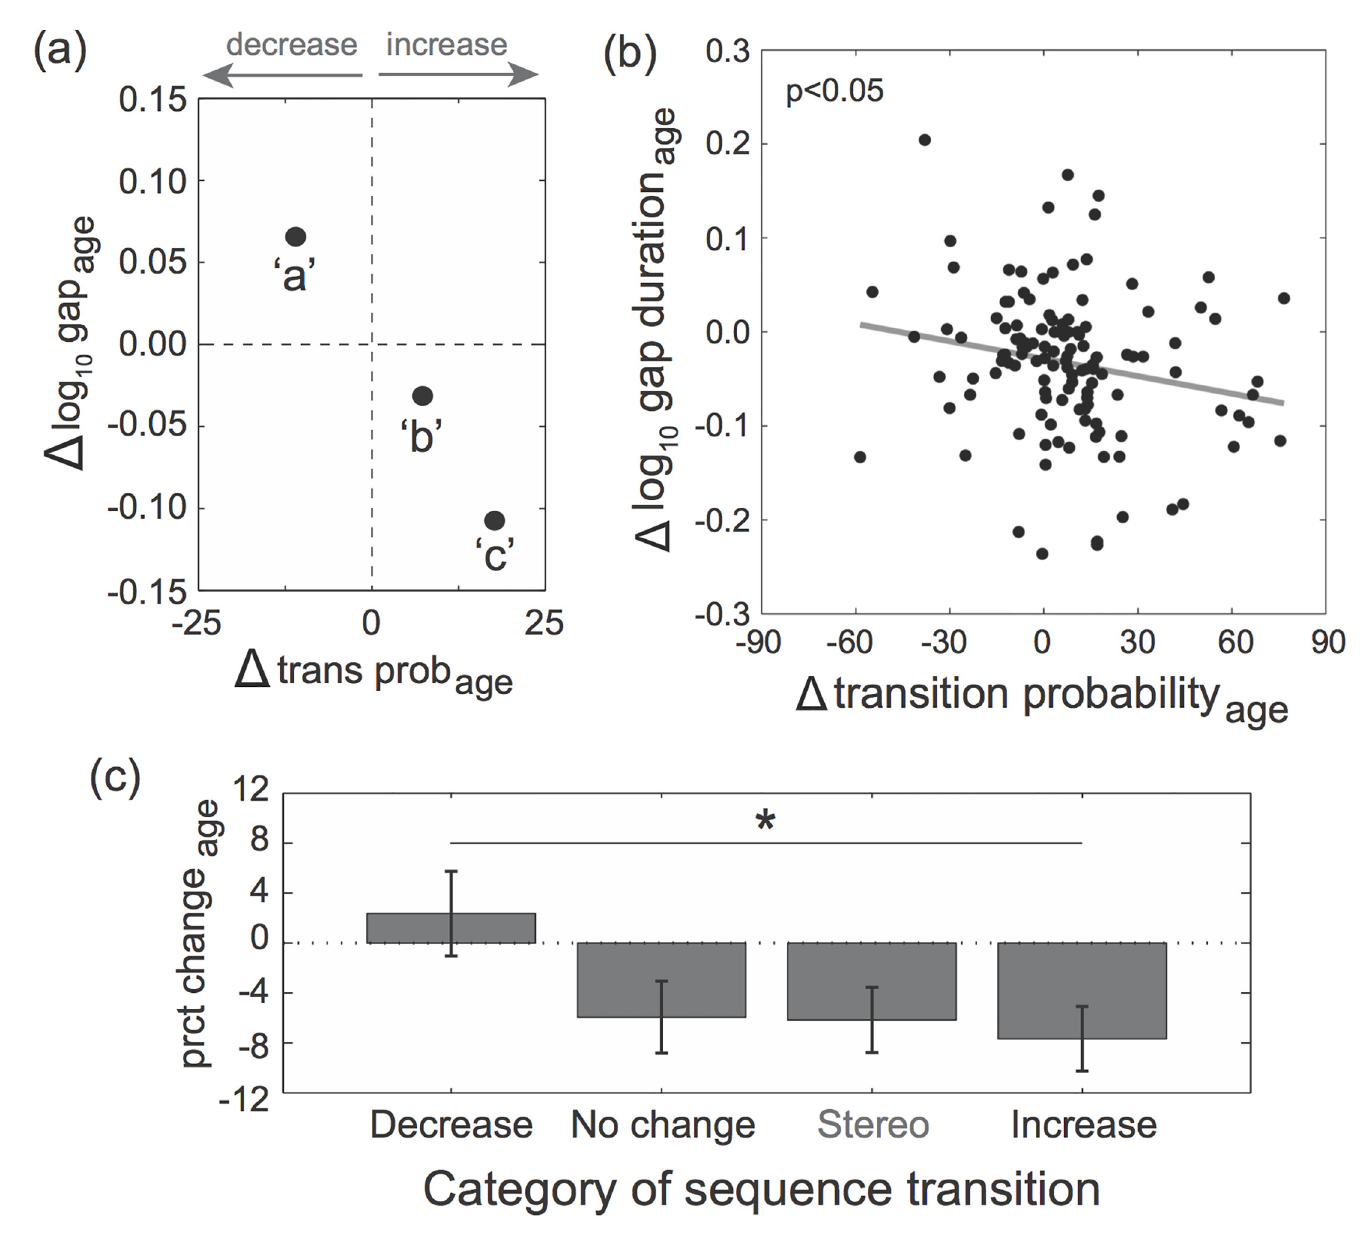
Fig 3. Relationship between age-dependent changes to transitions probabilities and gap durations within branch points. (a). An example of age- dependent changes to gap durations as a function of age-dependent changes to transition probabilities. Gap durations decreased for the two transitions that increased in prevalence whereas the duration of the gap for the transition that became less prevalent over time increased. (b). There was a significant negative relationship between age-dependent changes to transition probabilities and log 10 gap durations (F 1,108.4 = 5.3, p = 0.0230; slope = -0.063 ± 0.027). (c). The magnitude of change (percent change) in gap durations varied depending on whether the prevalence of a transition within a branch point significantly decreased, did not significantly change, or significantly increased (Likelihood ratio test) over time. Also included in the analysis was the percent change in gap durations for transitions within stereotyped sequences (data from [34]). The magnitude of change in gap durations was significantly different between transitions that significantly decreased and transitions that significantly increased in transition probability over time (Tukey ’ s HSD, p < 0.05) and nearly identical between stereotyped transitions and branch point transitions that did not change in probability over